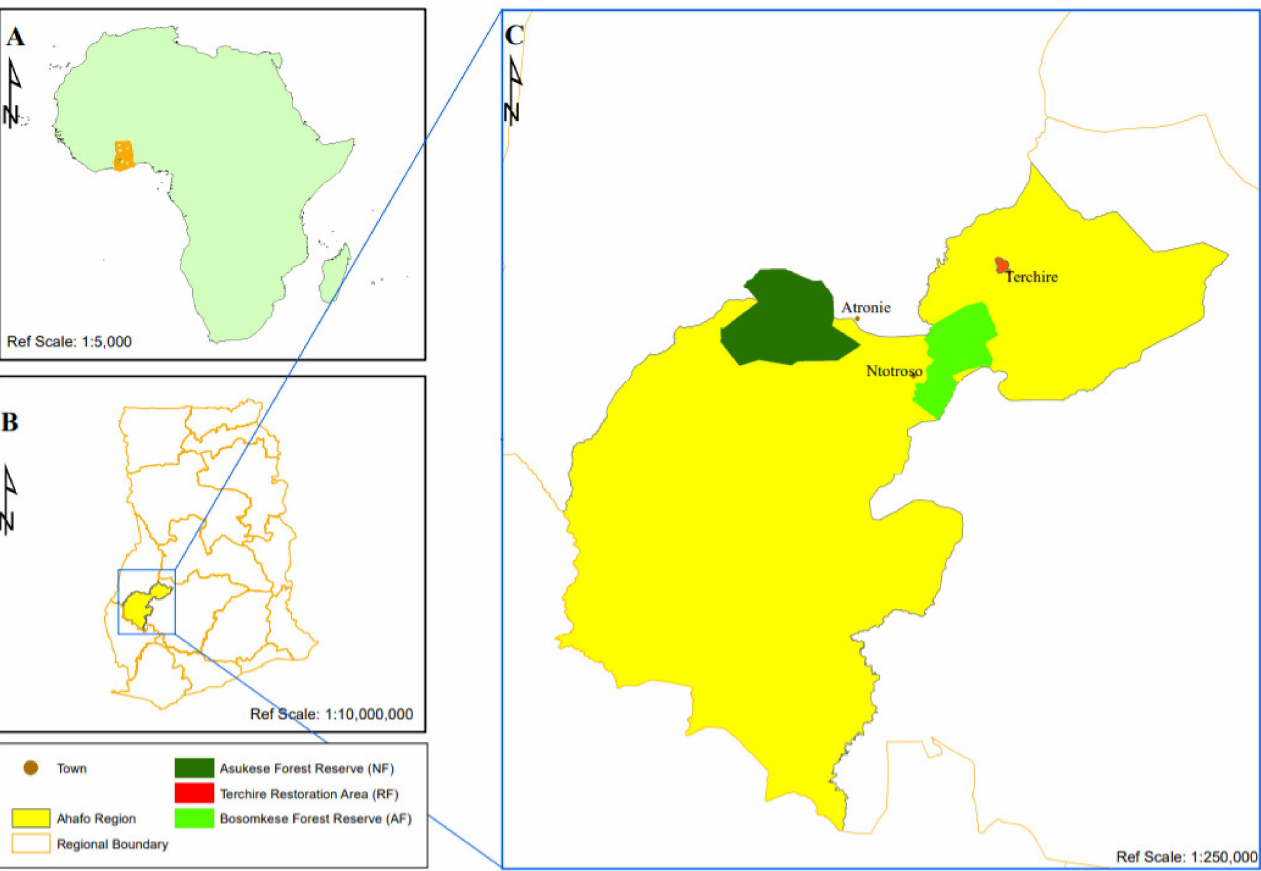
Figure 1. Map of the study region with the various ecosystem types. ( A ) Africa, ( B ) Ghana and ( C ) Bono regionThe RF located in Terchire (7 ◦ 14 (cid:48) 4.78 (cid:48)(cid:48) N, 2 ◦ 10 (cid:48) 49.88 (cid:48)(cid:48) W) is a post mine area that has been actively restored with both indigenous and exotic tree species (e.g., Morinda lucida Benth, Terminalia suberba Engl. & Diels, Albizia zygia (DC.) J. F. Machr., Cedrela odorata L., Mangifera indica L.) after soil improvement to provide essential ecosystem goods and services to society. On the other hand, AF (7 ◦ 6 (cid:48) 20.76 (cid:48)(cid:48) N, 2 ◦ 15 (cid:48) 22.64 (cid:48)(cid:48) W) is a forest reserve experiencing massive degradation. Because of its degraded nature, it has been subjected to agroforestry programs (food crops interplant with trees) to supply both food and energy needs as well as environmental benefits to fringe communities. In contrast, NF (7 ◦ 9 (cid:48) 13.72 (cid:48)(cid:48) N, 2 ◦ 31 (cid:48) 4.96 (cid:48)(cid:48) W) is a protected forest reserve under strict restrictions against anthropogenic activities